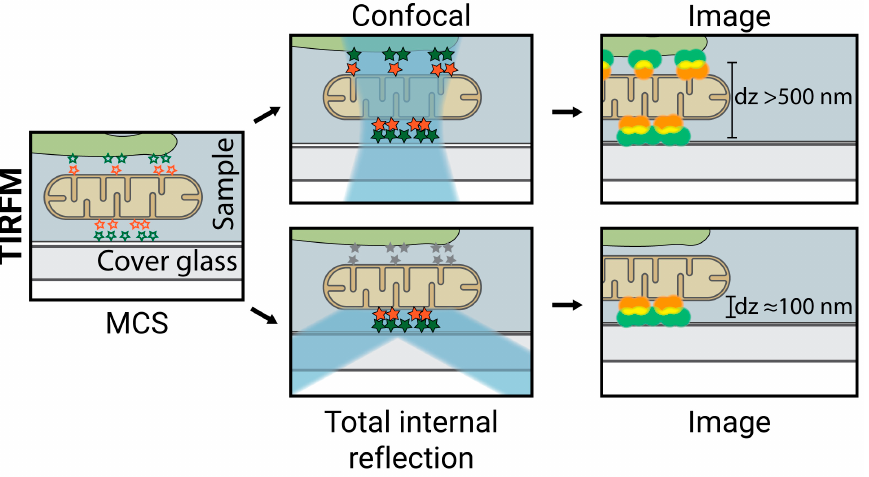
Figure 4. Total Internal Reflection Microscopy (TIRFM). In contrast to LSCM, in TIRFM, the sample is illuminated with light that is totally internally reflected at the interface of the cover glass and the sample and does not penetrate the sample beyond ≈ 100 nm. The acquired images are not contaminated by fluorophores from other out-of-focus planes. Lateral resolution > 200 nm; axial resolution ≈ 100 nm.